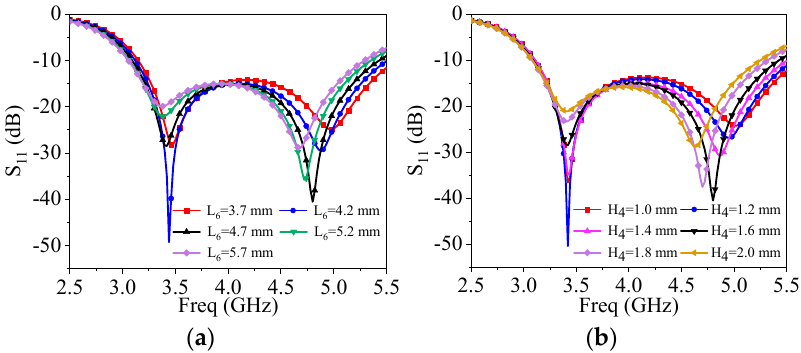
Figure 7. Parametric analysis of Y-shaped feeding lines. ( a ) L 6 , ( b ) H 4 .